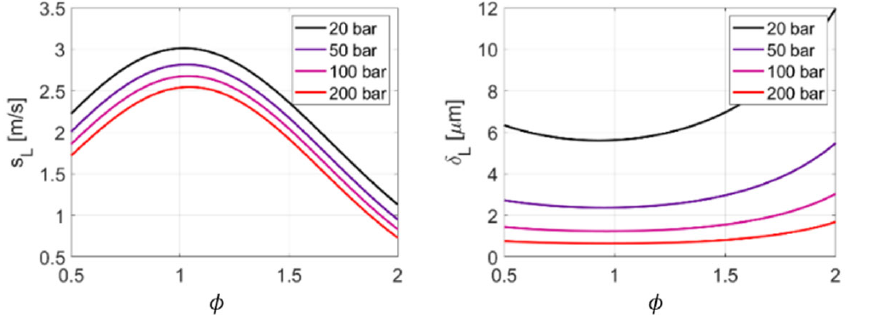
Figure 7. Laminar flame parameters for methane–oxygen combustion at 𝑇 (cid:3036) (cid:3404) 350 𝐾 .